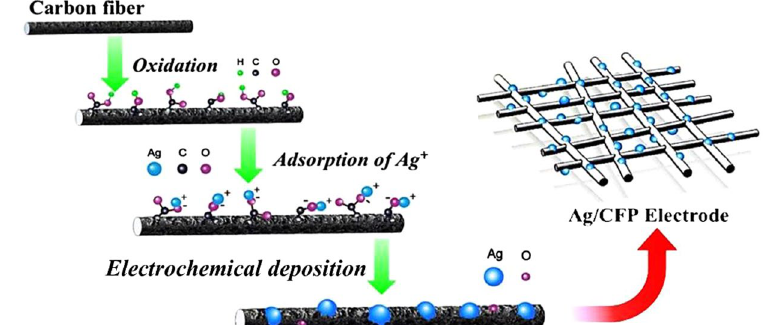
Figure 1. Schematic diagram of the synthesis process of Ag/CFP